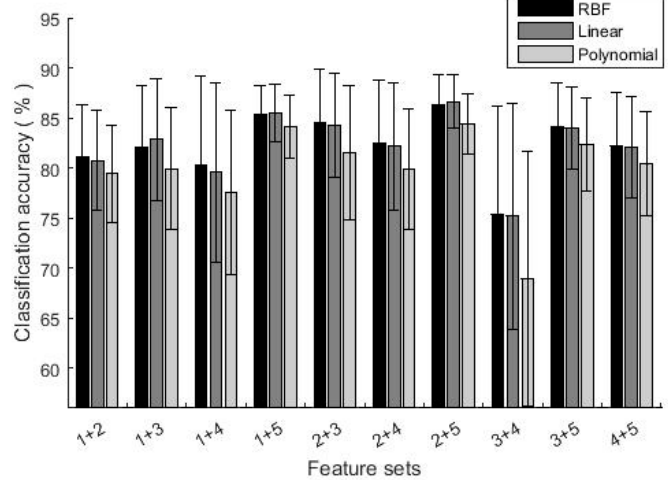
Figure 4. The classification accuracy using two feature sets.